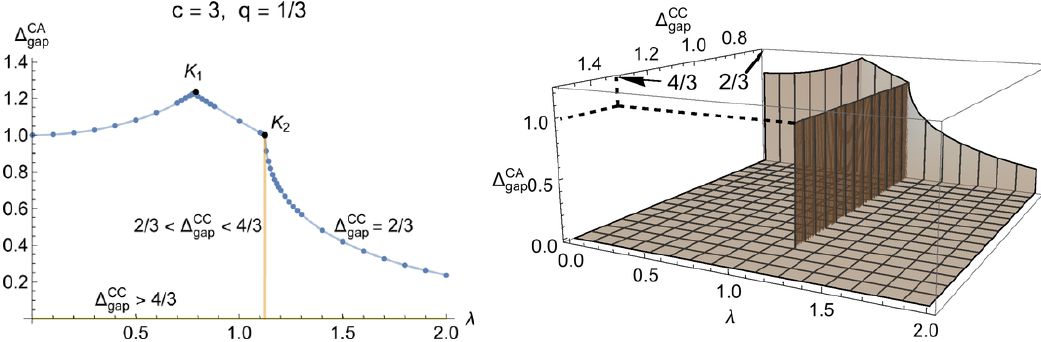
Figure 5. Left: upper bounds on the gap in the CA channel (cid:1) CA in the case of c = 3 and external charge q = 1 the chiral ring coe(cid:14)cient (cid:21) and the gap in the CC channel (cid:1) CC The blue, yellow, and green curves are the bootstrap bounds with (cid:1) CC > 4 (cid:1) CC , respectively. Right: the three-dimensional visualization of the same plot. The peak for gap 3 2 3 < (cid:1) CC is saturated by the point ( R; b ) = gap (cid:20) 3 4 at which the OPE coe(cid:14)cient for the ( a; a ) primary (cid:30)